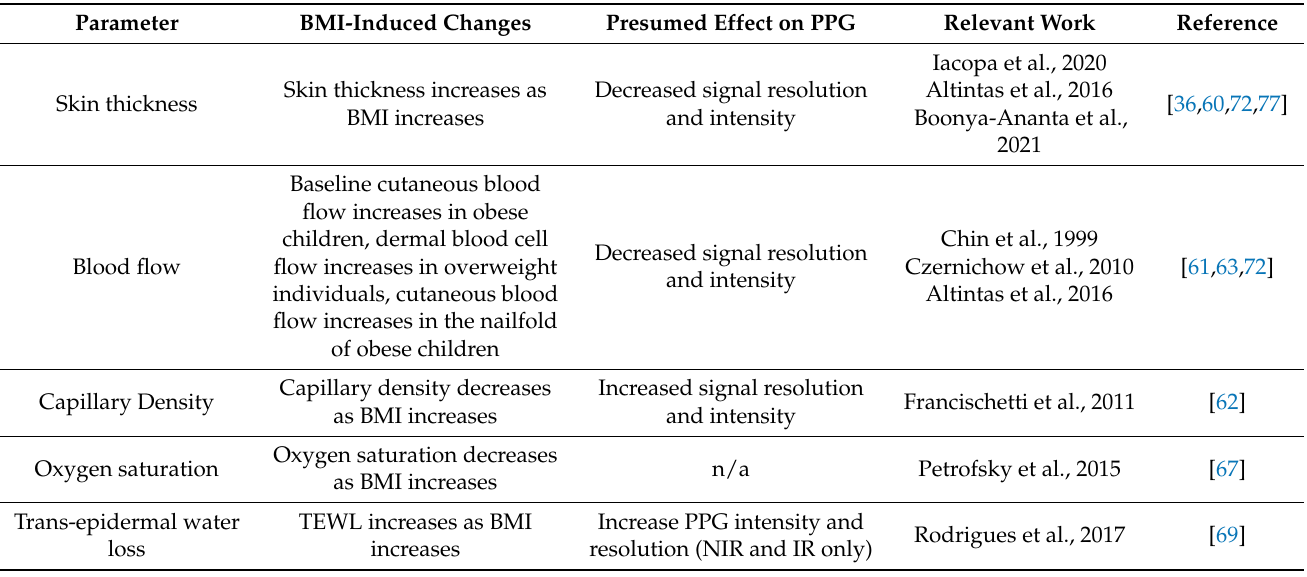
Table 2. Obesity-induced effects on